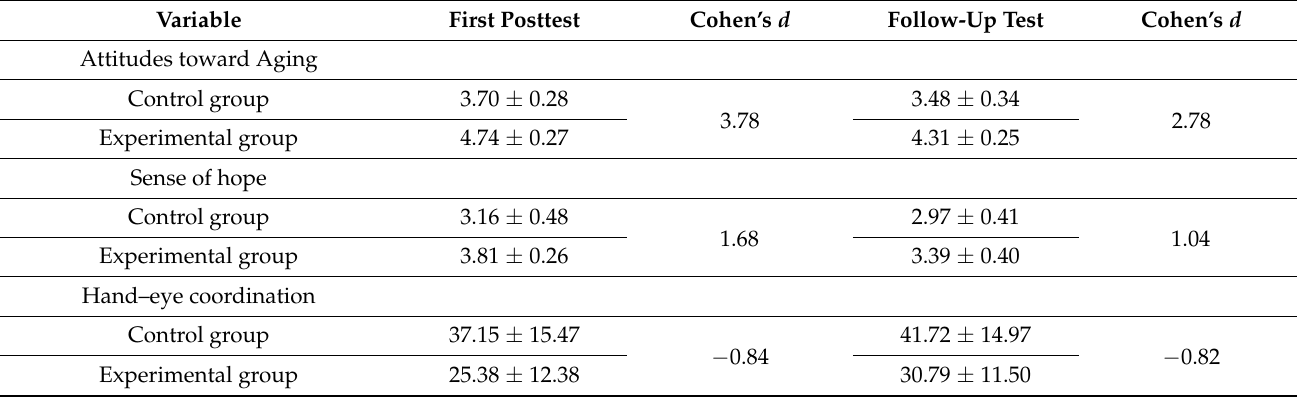
Table 4. Effect size (Cohen’s d ) of the intervention on attitudes toward aging, sense of hope, and hand–eye